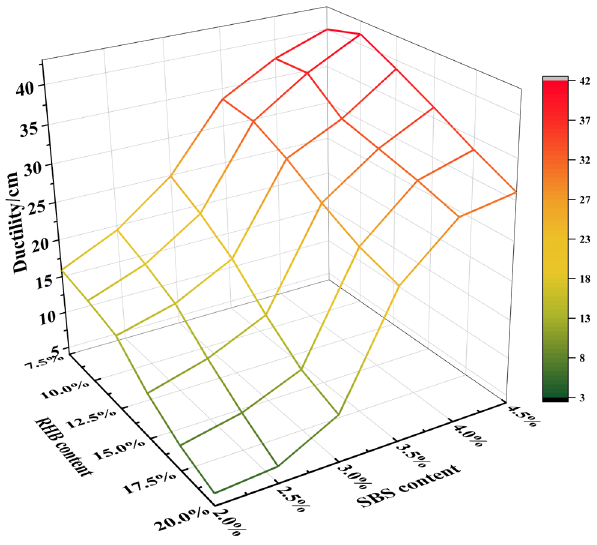
Figure 5. Ductility of composite-modified asphalt.